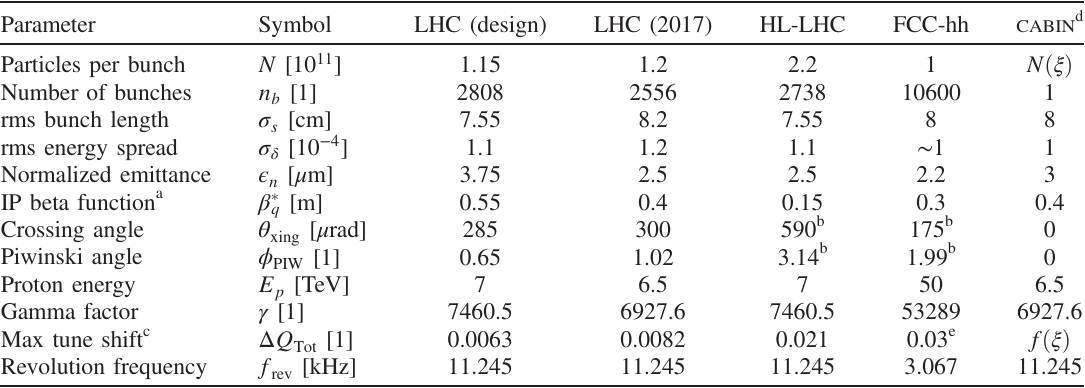
TABLE I. Values for parameters in present and future circular colliders, in addition to the default settings of CABIN